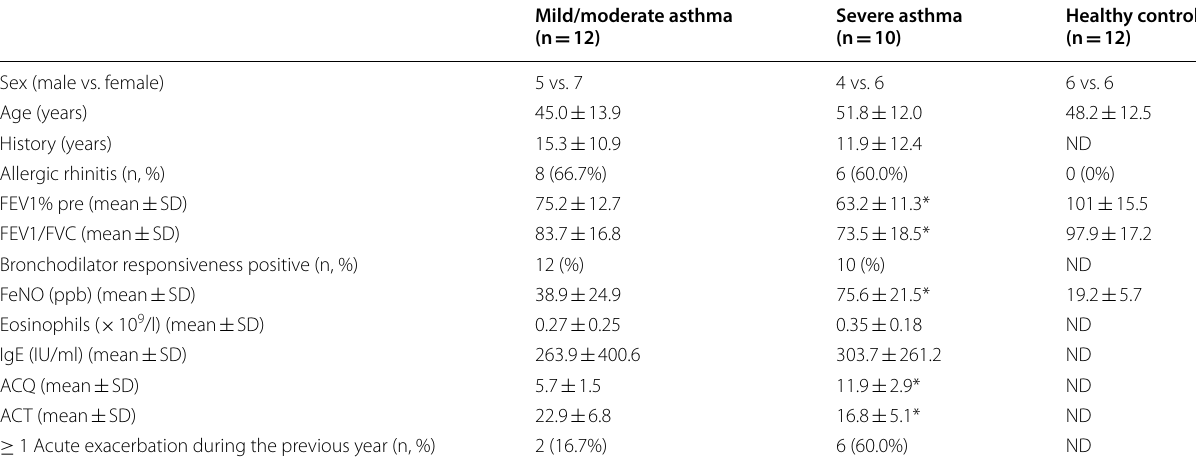
Table 1 Demographic and clinical characteristics of participants with severe or mild/moderate asthma and control